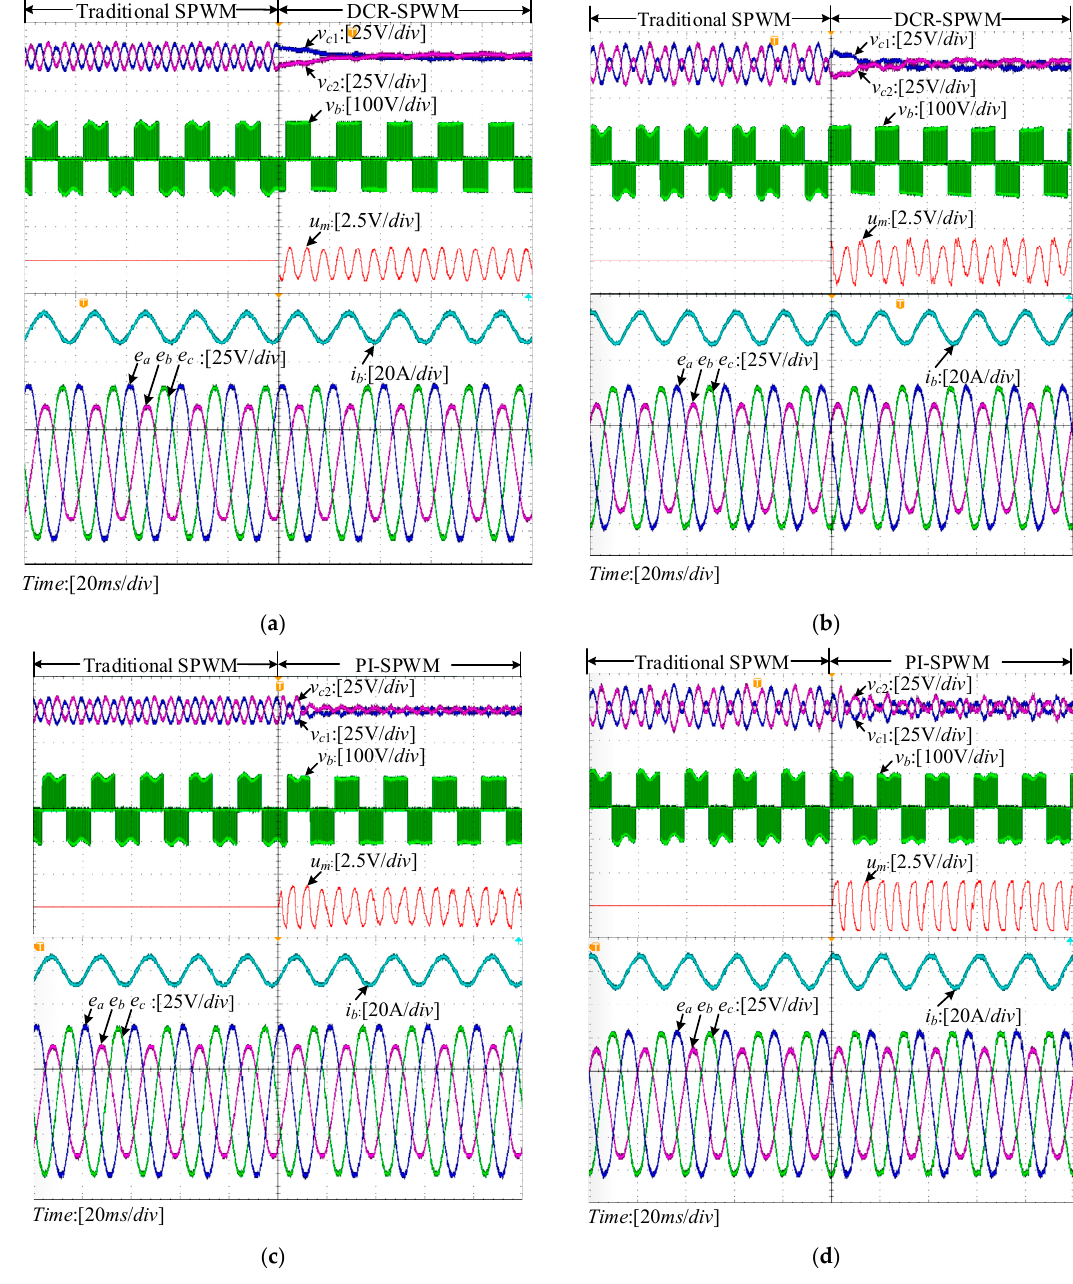
Figure 11. Experimental waveforms under different φ ui conditions: ( a ) DCR-SPWM φ ui = 0, λ = 0.1, v c 1av − v c 2avg = 0; ( b ) DCR-SPWM φ ui = − π /4, λ = 0.1, v c 1avg − v c 2avg = 0; ( c ) PI-SPWM φ ui = 0, λ = 0.1, v c 1avg − v c 2avg = 0; ( d ) PI-SPWM φ ui = − π /4, λ = 0.1, v c 1avg − v c 2avg = 0.